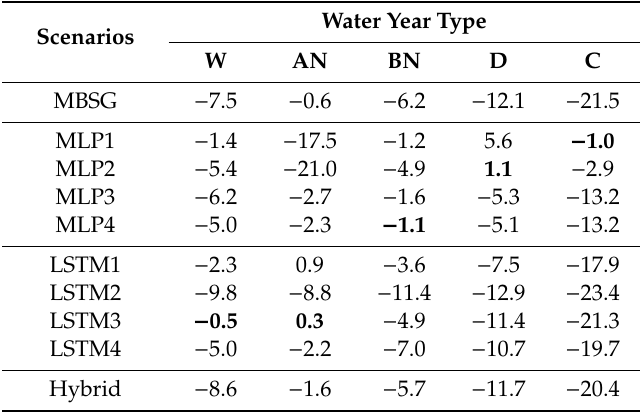
Table A3. Percent di ff erences (%) between the standard deviation of reference salinity and simulated salinity at Martinez in di ff erent types of water years.